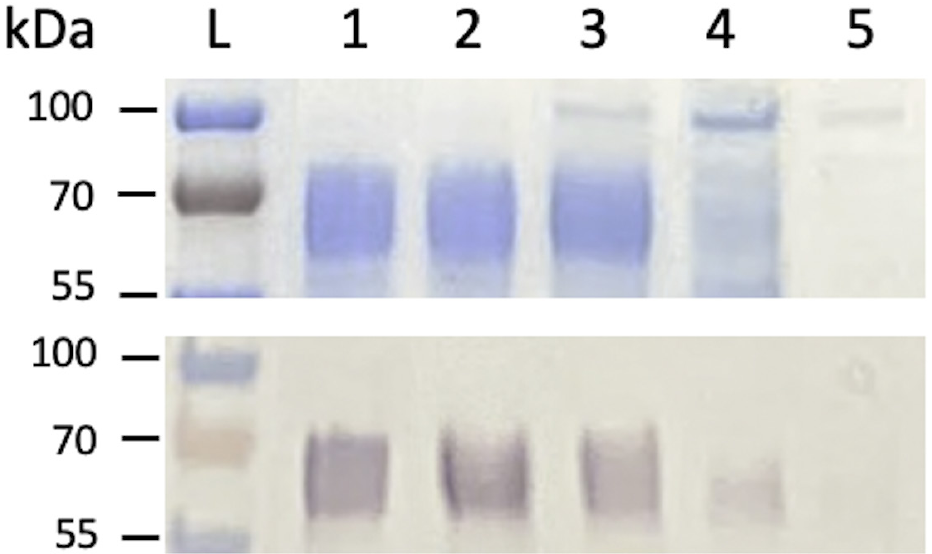
Figure 2. SDS-PAGE and Western blot of Tyrp1 and OCA3-related mutants. SDS-PAGE (top panel) and Western blot (bottom panel) showing the expression of Tyrp1 and OCA3-related mutants after purification by IMAC and GF chromatography. From the left: L, protein ladder; Tyrp1; 2, D308N; 3, R326H; 4, H215Y, and 5, C30R.